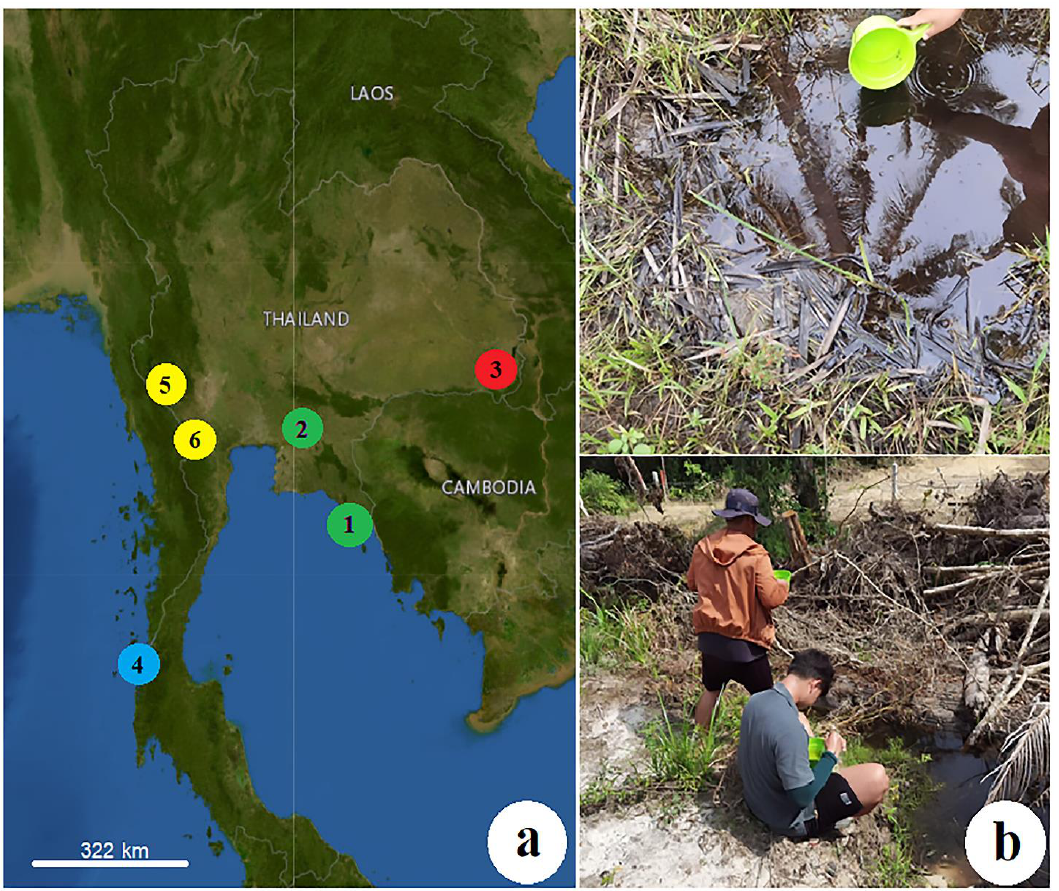
Figure 1. Locations of the sample collection sites ( a ) and Lutzia larval collection method used in this study ( b ). Lutzia mosquito samples were gathered from six provinces in four geographical regions of Thailand, including Trat (1), Chachoengsao (2) in the eastern region (green), Ubon Ratchathani (3) in the northeastern (red), Ranong (4) in the southern region (blue), Kanchanaburi (5), and Ratchaburi (6) in the western region (yellow). This map was made available by the USGS National Map Viewer (public domain): http://viewer.nationalmap.gov/viewer/, accessed on 1 October 2022.